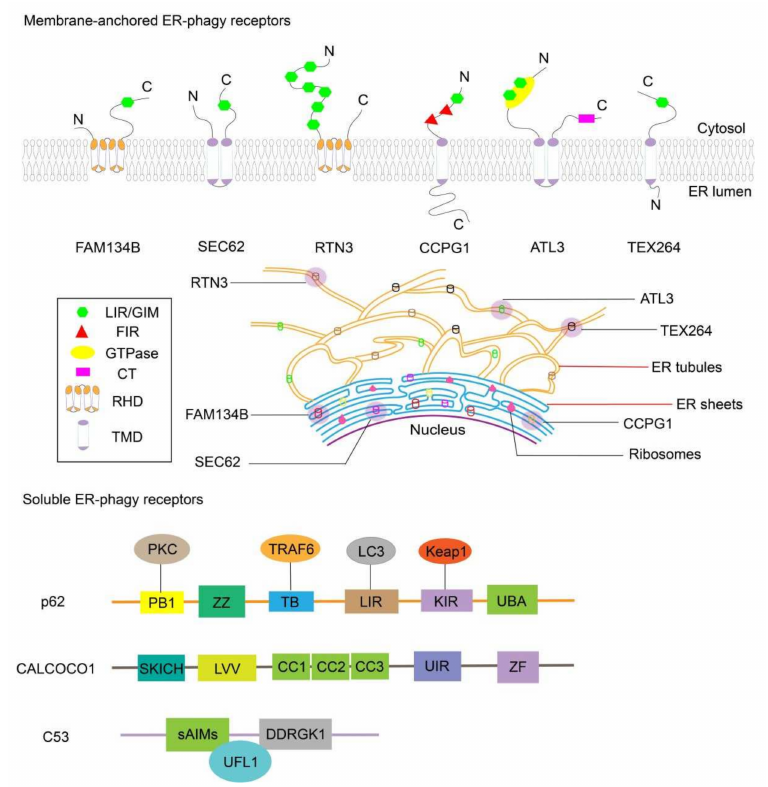
Figure 1. The essential receptors of ER-phagy. Generally, FAM134B, SEC62, and CCPG1 are located in the ER sheets, while RTN3, ATL3, and TEX264 exist in the tubular ER; meanwhile, p62, CALCOCO1, and C53 are three soluble receptors that are distributed in different regions. Although they have various functional motifs and locations, they all play indispensable roles in ER-phagy and have unique interactions with the development of cancer. For instance, FAM134B and RTN3 are activated upon amino acid deprivation, while SEC62 and CCPG1 play more roles in ER-phagy induced by drugs. In its relationship with tumors, FAM134B can inhibit tumor cell migration, while SEC62 can promote the invasion and metastasis ability of cancer cells. The other functions of these receptors in ER-phagy and cancer require further